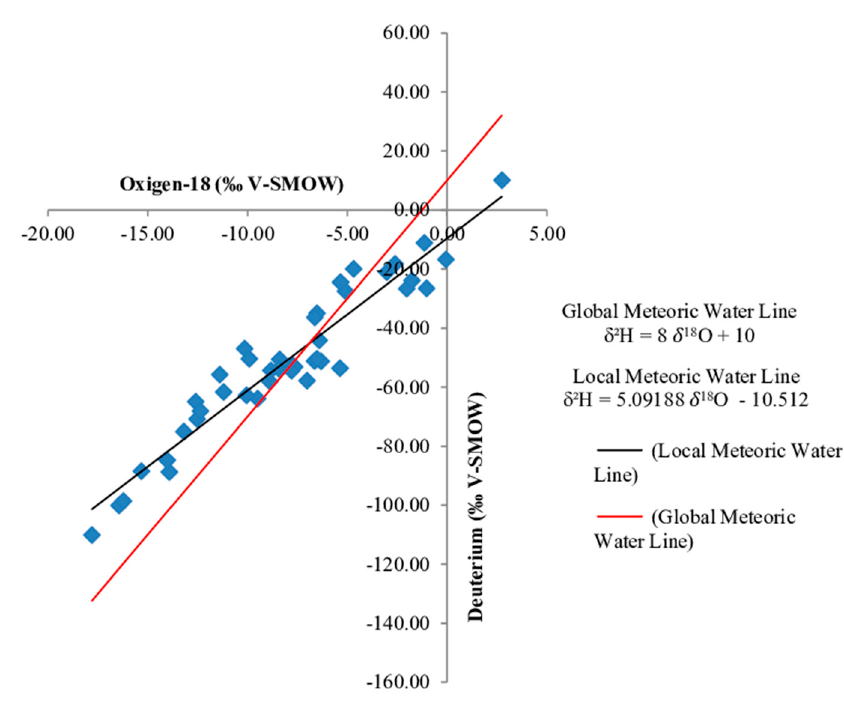
Figure 5. Plot of local meteoric water line (LMWL) for precipitation samples, and the global meteoric water line (GMWL). Table 2. Ordinary least-squares linear regression parameters from stable isotopic compositions of all water sources.